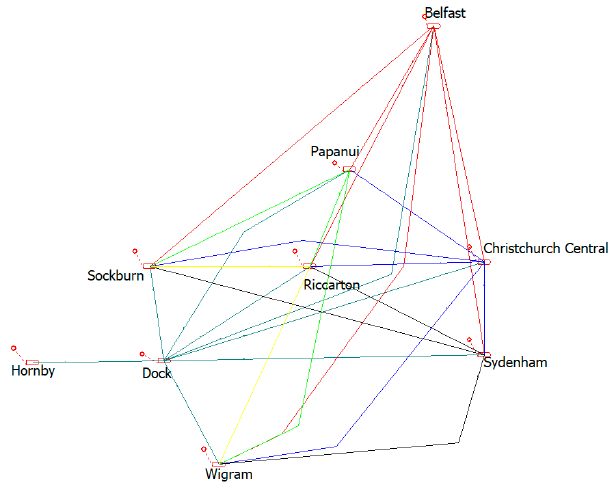
Figure 11. Refined schematic representation of the transportation network.